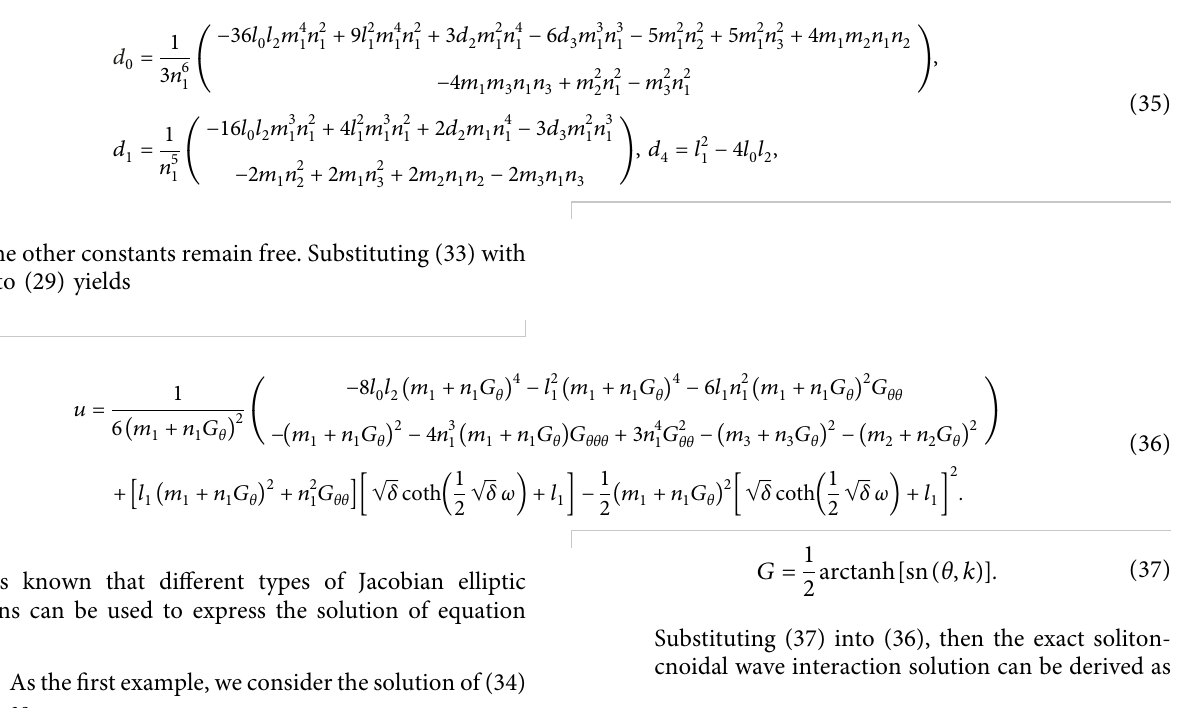
Figure 1: Profile of equation (30) by choosing suitable parameters: l (a) Perspective view of the wave at t � − 6. (b) Perspective view of the wave at t � 0. (c) Perspective view of the wave at t �